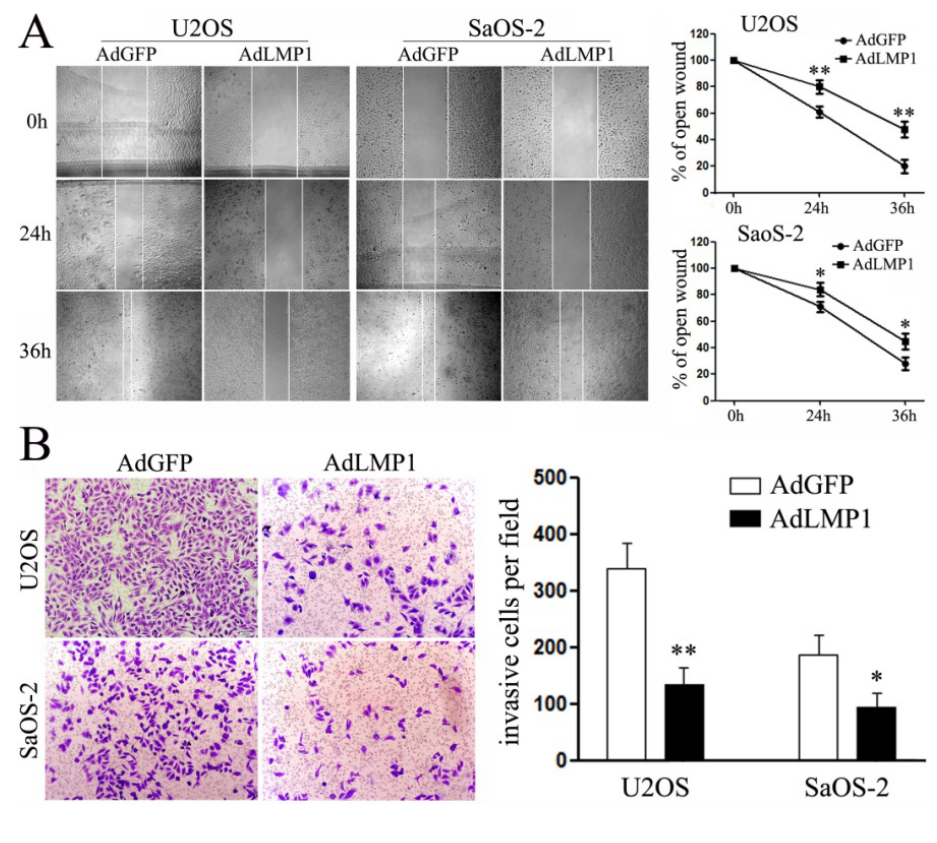
Figure 4. Overexpression of LMP-1 suppressed OS cell migration and invasion. ( A ) Wound healing assays in U2OS and SaOS-2 cells treated with LMP-1 adenovirus for 48 h of infection. Overexpression of LMP-1 resulted in a significant reduction in cell migration during the closing of the artificial wound; ( B ) Representative images ( left ) and bar graphs ( right ) depicting the invasion ability of U2OS and SaOS-2 cells after LMP-1 infection (×100). Ectopic expression of LMP-1 suppressed cell invasion of OS cells. ** p < 0.01; * p <